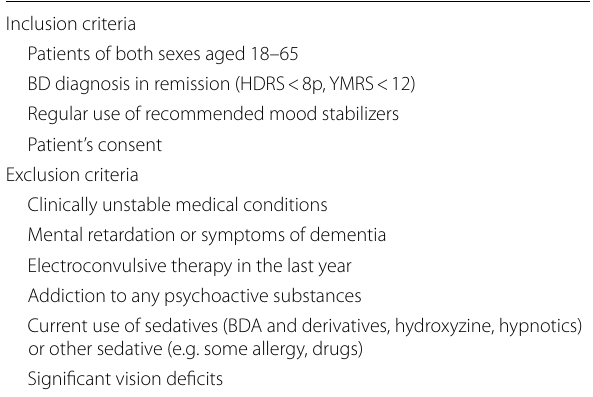
Table 1 Inclusion and exclusion criteria for